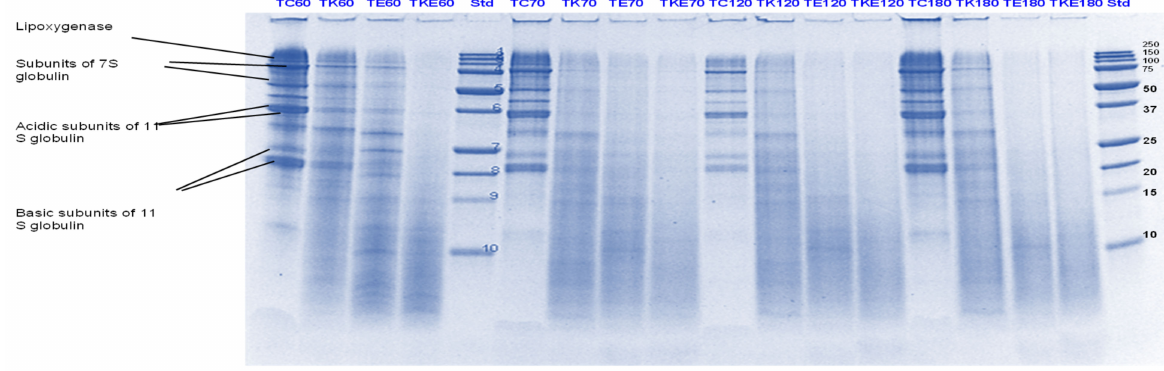
Figure 8. Tricine SDS-PAGE electrophoretogram of tofu (T) digest after 60, 70, 120 and 180 min of simulated oral-gastric-small intestinal digestion in the presence or absence of Hayward (K) kiwifruit extract. TC, tofu (T) control without any digestive enzymes; TK, with added green kiwifruit extract but no digestive enzymes; TE, with digestive enzymes but no added kiwifruit extract; TKE, with both digestive enzymes and green kiwifruit extract. Bands (1–10) in the molecular weight standard lane correspond to molecular weights 250, 150, 100, 75, 50, 37, 25, 20, 15 and 10 kDa. The num- ber 60 is the gastric digestion time following 2 min of oral digestion. Numbers 70, 120 and 180 are the total digestion times in oral-gastro-small intestinal digestion (including the first 60 min of gastric digestion).